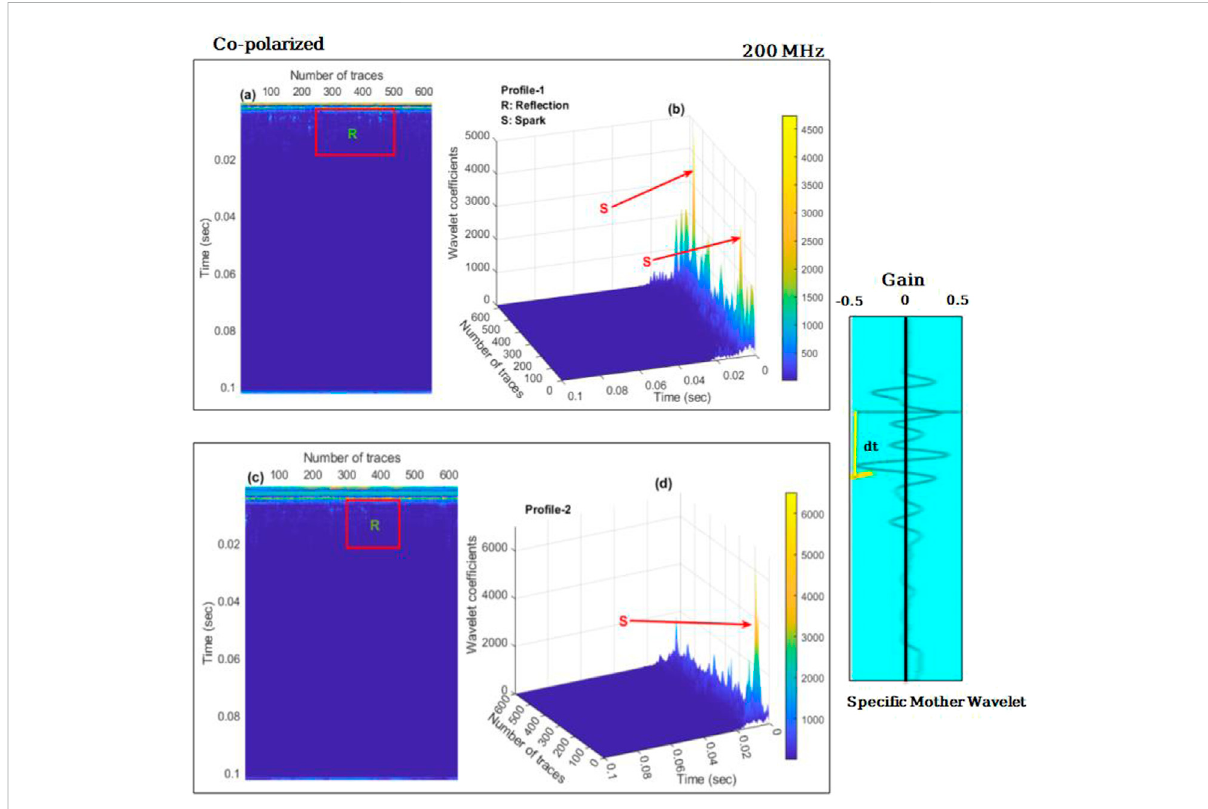
FIGURE 5 Continuous wavelet Transform (CWT) representation using co-polarized GPR data acquired at 200 MHz frequency, whereas (A) CWT in 2-D, where (R) represents the event re fl ection of pro fi le 1. (B) After applying the CWT to 3-D GPR data In the fi gure, clear sparks (s) represent the buried archeology of the pro fi le one test site (C) CWT in 2-D, where R represents the event re fl ection of pro fi le 2. (D) 3-D representation of GPR data using theCWTinthe fi gure, clearsparks (s)represents theburied archeology ofthepro fi letwo testsite.Aspeci fi cmotherwavelet with gain( − 0.5- 0- + 0.5) is used for